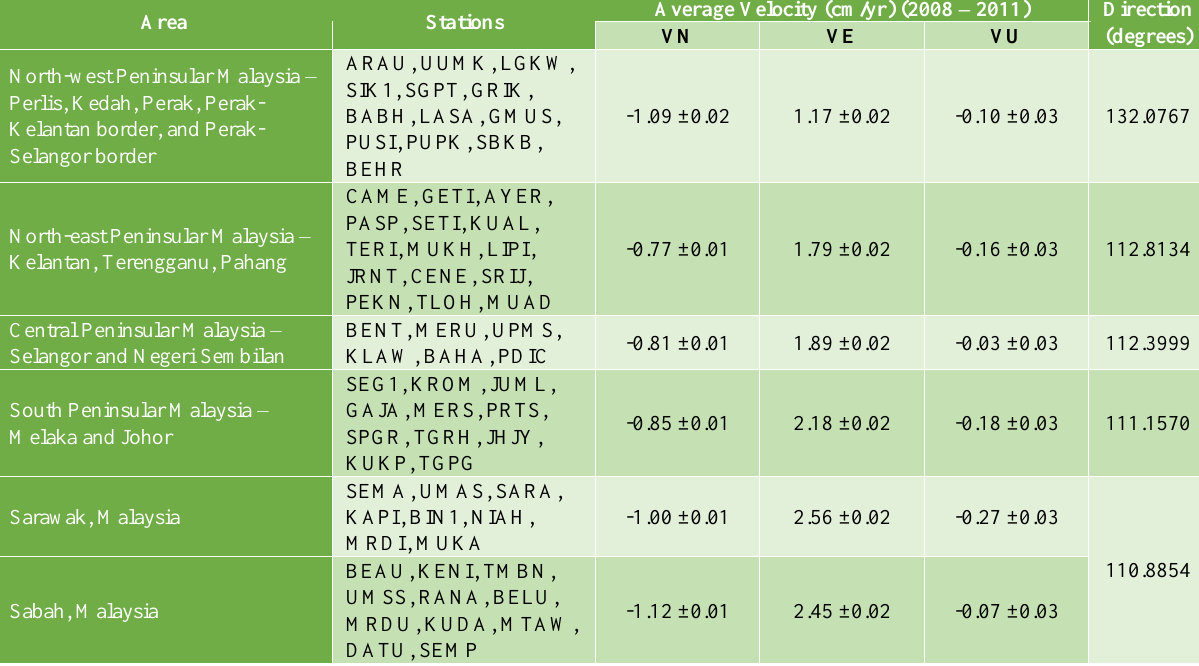
Table 3. Averaged velocities of Malaysia and their directions, categorised by area, from linear regression analysis of MyRTKnet station positions from 2008 to 2011. VN, VE, and VU represent the north component velocity, east component velocity, and up component velocity, and their standard errors, respectively